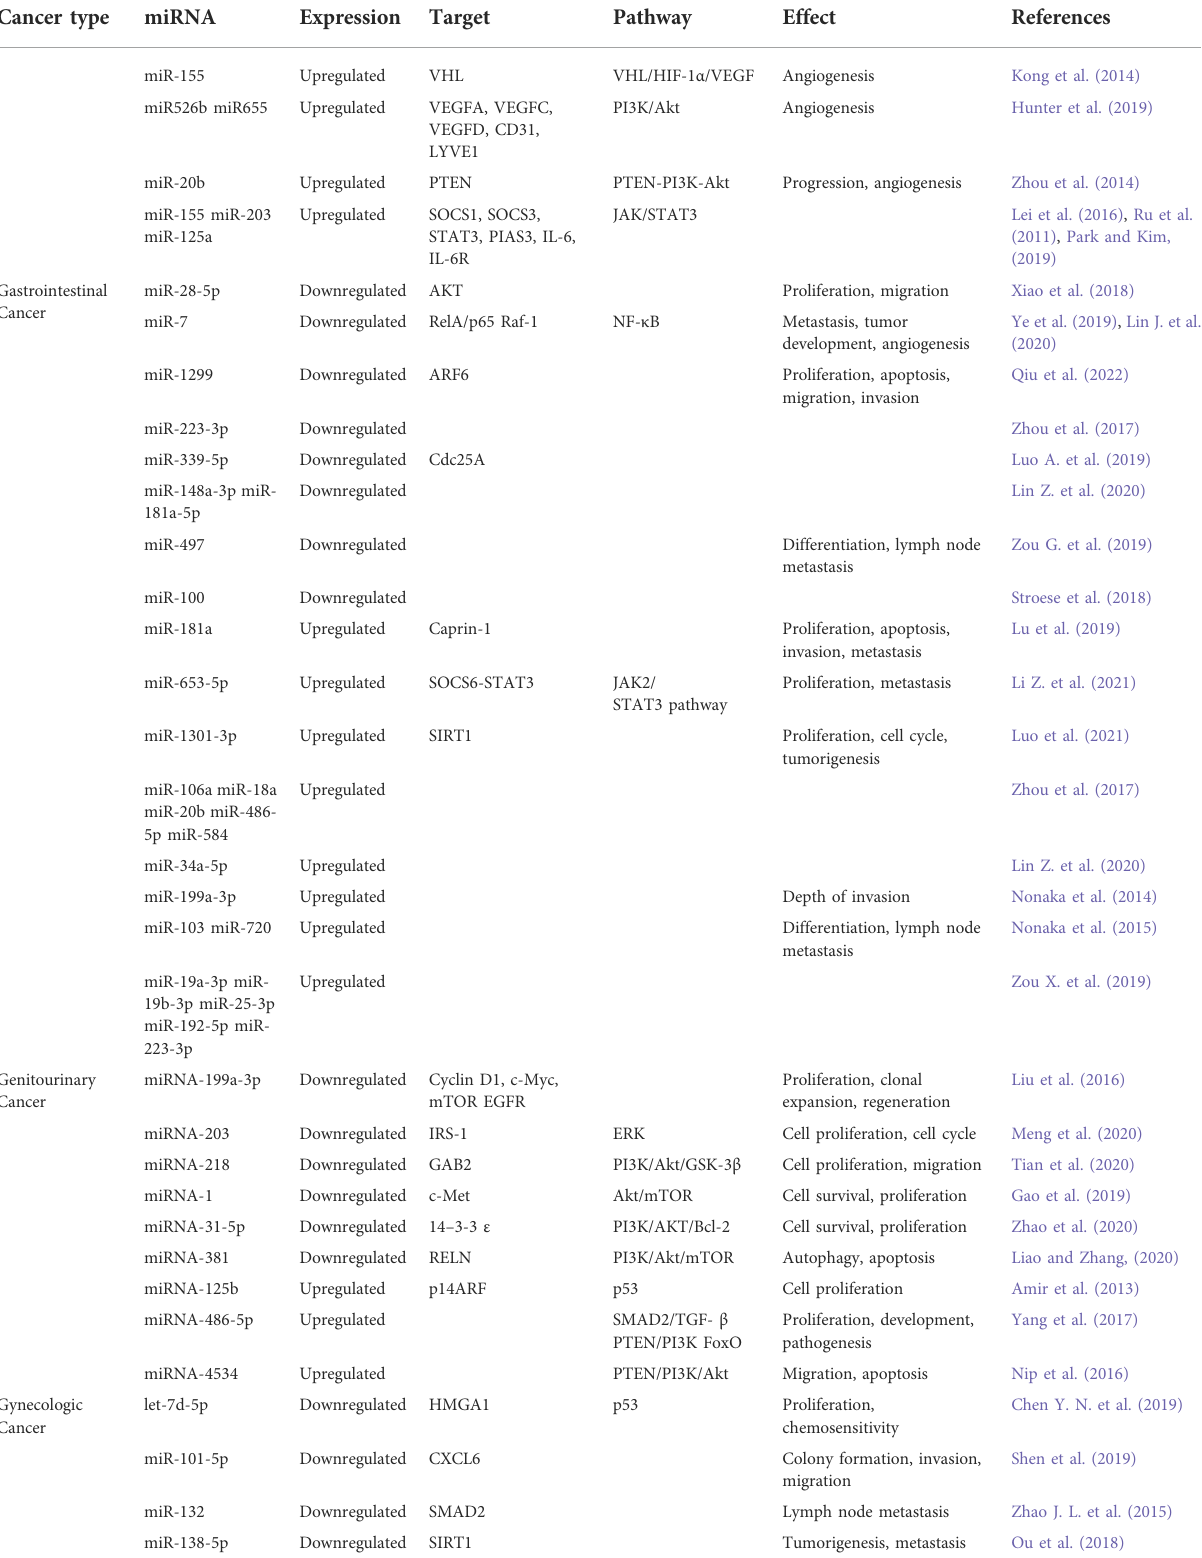
TABLE 1 ( Continued ) Examples of miRNAs and their roles in different